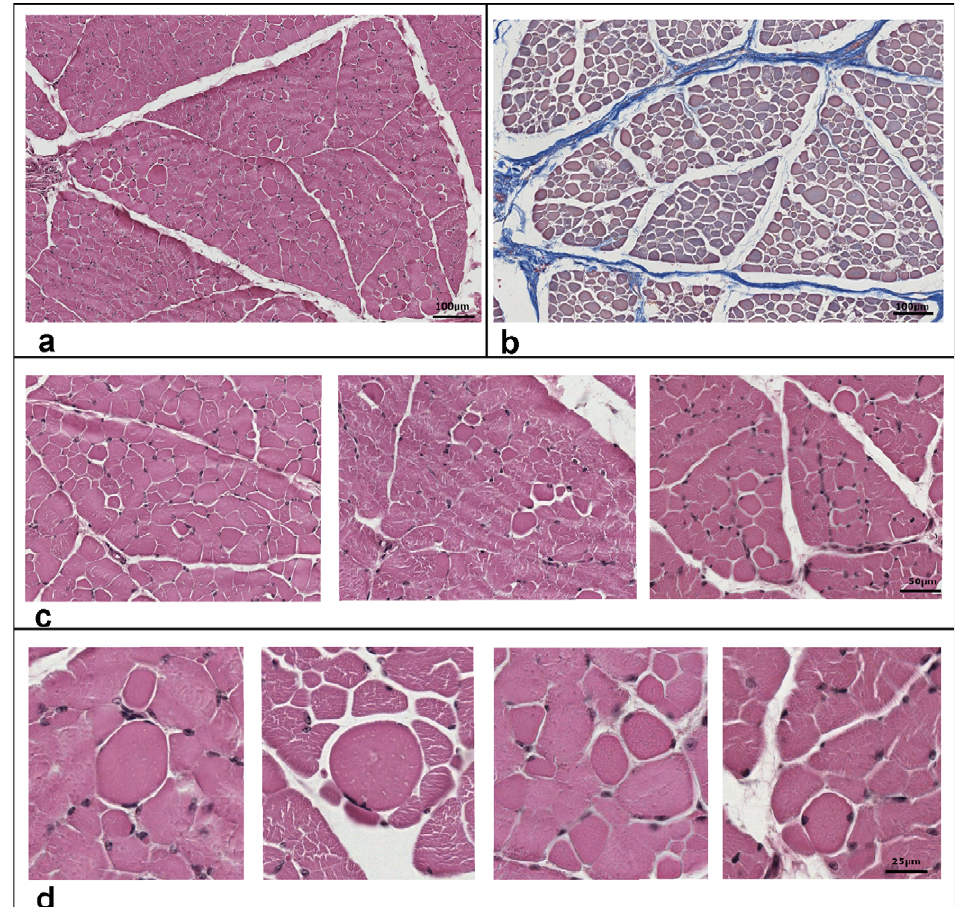
Figure 3. Histological features of semimembranosus muscle of the studied case. Transversal sections from muscle biopsies were stained with hematoxylin and eosin ( a , c , d ) or with Azan – Mallory method ( b ) to identify collagen fibers. Enlarged round shaped fibers are highlighted in panels ( c , d ). The percentage value of round shaped fibers (5.3%) was determined as the ratio of muscle fibers that lost their main shape and/or took a round shape to the total muscle fibers in the region. Scale bars correspond to 100 m in panels ( a , b ), and 50 and 25 m in panels c and d, respectively.